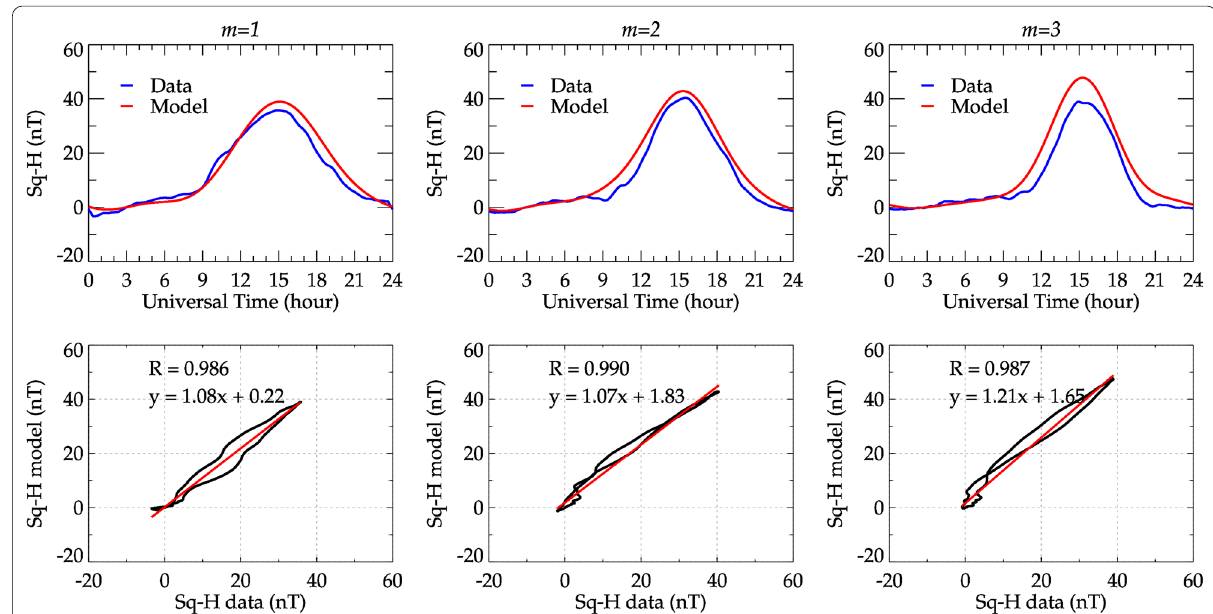
Fig. 5 Top panels correspond to the Sq-H field obtained for CXP using the magnetic field data (blue) and the SQRF model (red) for January to March 2019. The bottom panels correspond to the dispersion plots of the Sq-H field for each of the presented months, respectively